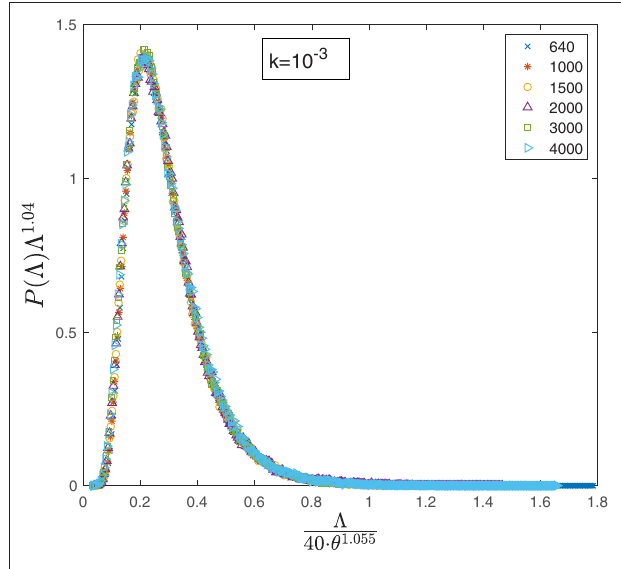
FIGURE 9 | Data collapse for the distribution of the largest cluster P ( 3 ) at k = 10 − 3 .